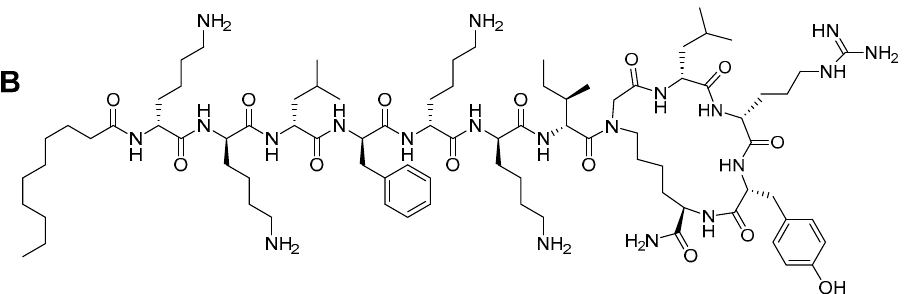
Figure 1. ( A ) General scheme for the synthesis of C -locked peptides. ( B ) An example is the lipidated C -locked BP214 analog 13 . Table 1. Minimum inhibitory concentration values in µg/mL(µM) and % hemolysis against human erythrocytes at 150 µM.